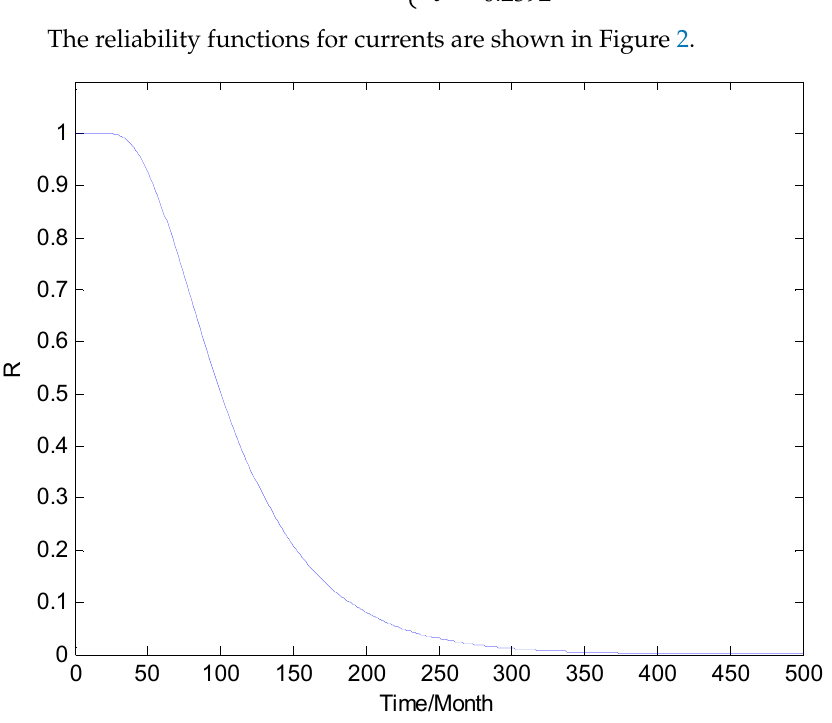
Figure 2. Momentum wheel reliability curve based on current degradation.